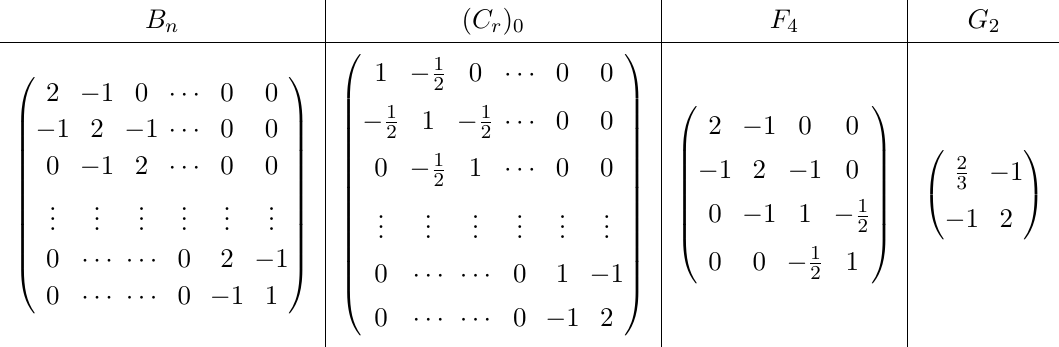
Table 4 . Ω s for non-simply-laced g